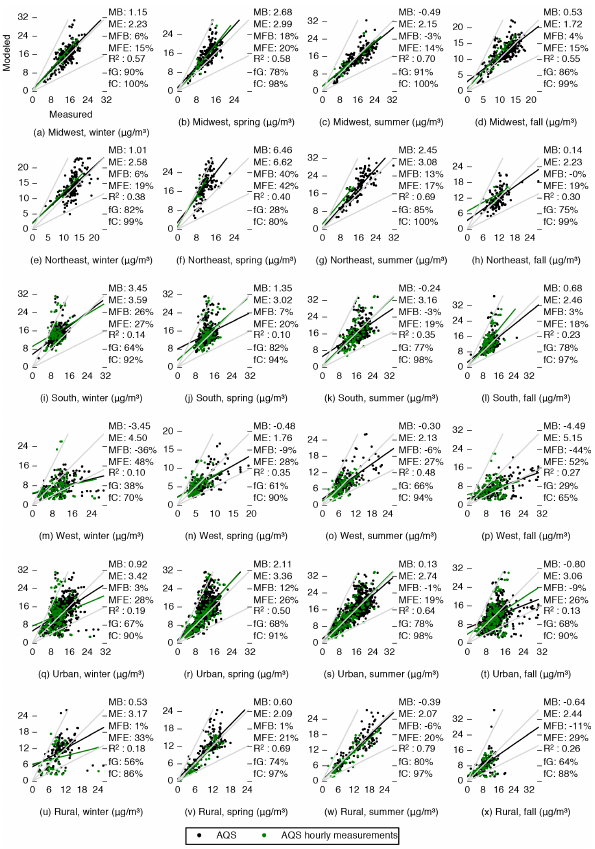
Figure 5. Comparison of measured and modeled PM 2 . 5 concentra- tions disaggregated by season and region. Region boundaries are shown in Fig. 2.